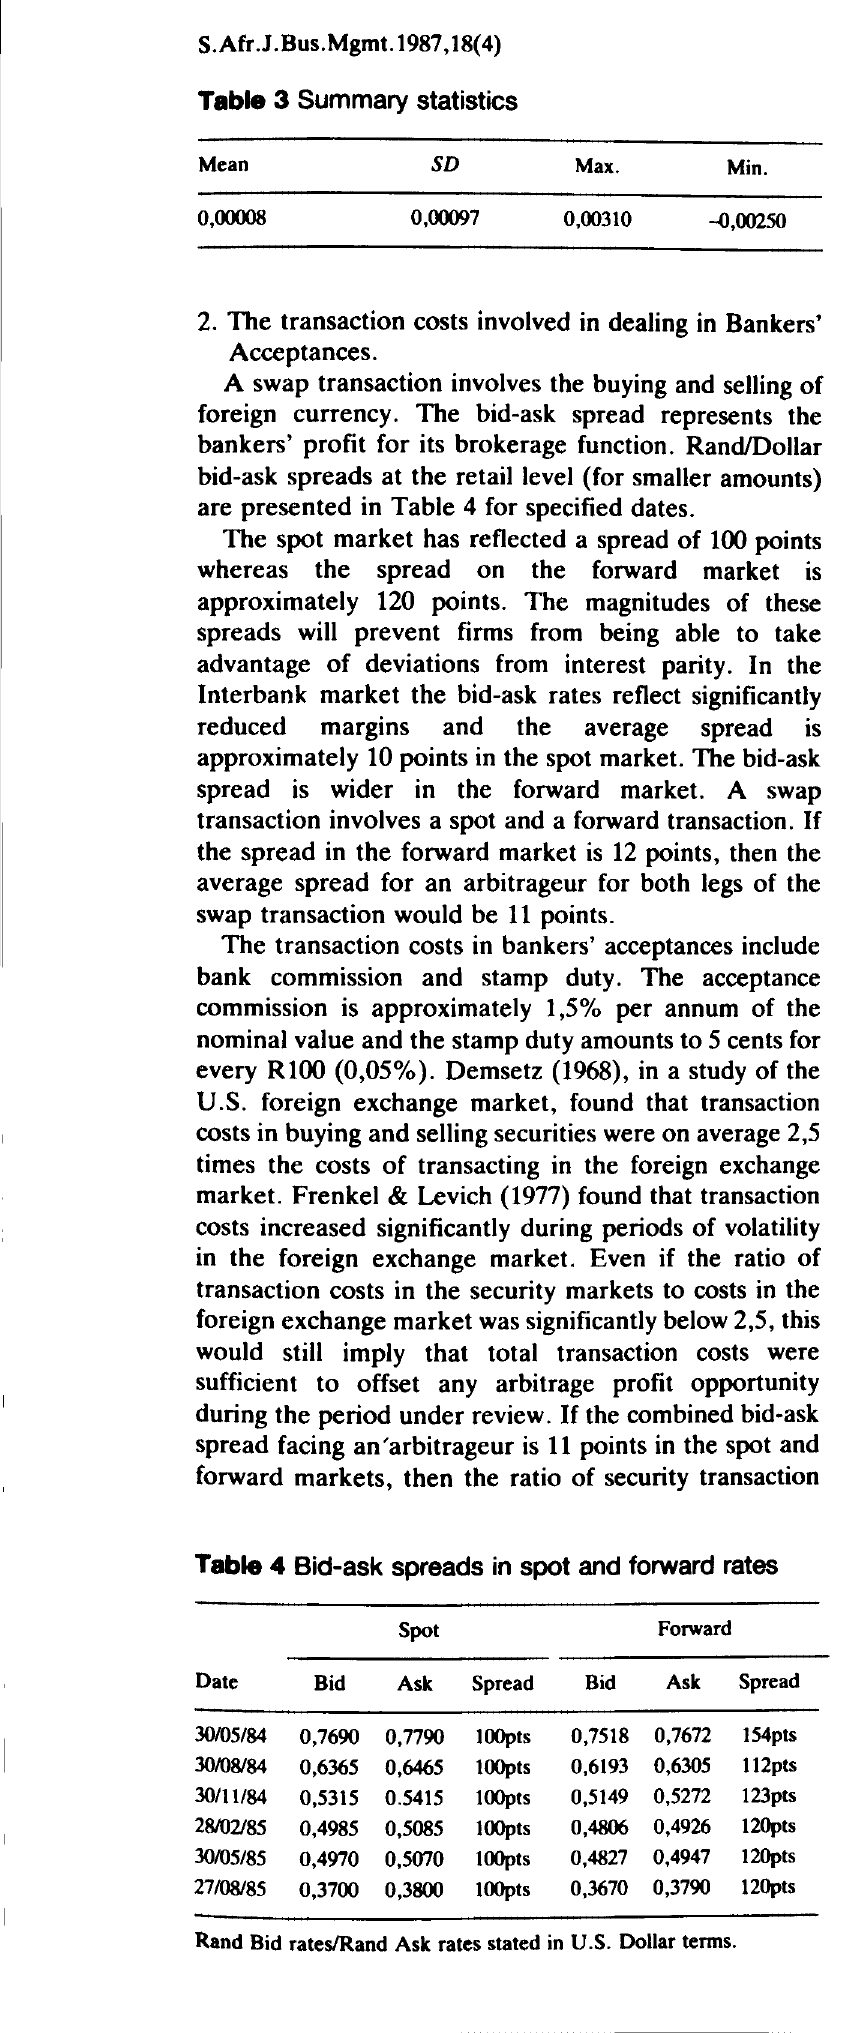
Table 3 Summary